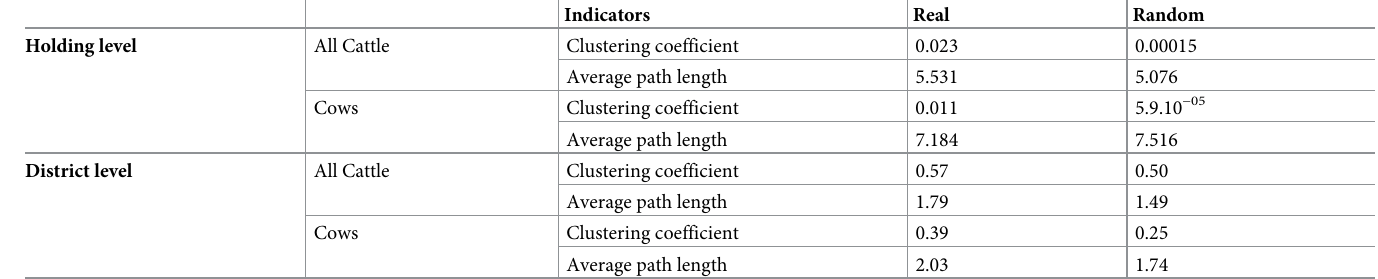
Table 5. Clustering coefficient and average path length for the global real and random networks in Paraguay. The nodes and links were aggregated from 2014 to